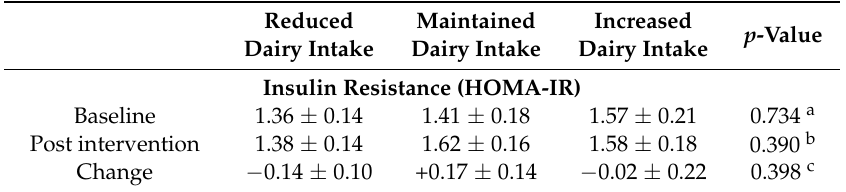
Table 3. Changes in HOMA-IR for each randomized group after the intervention period.